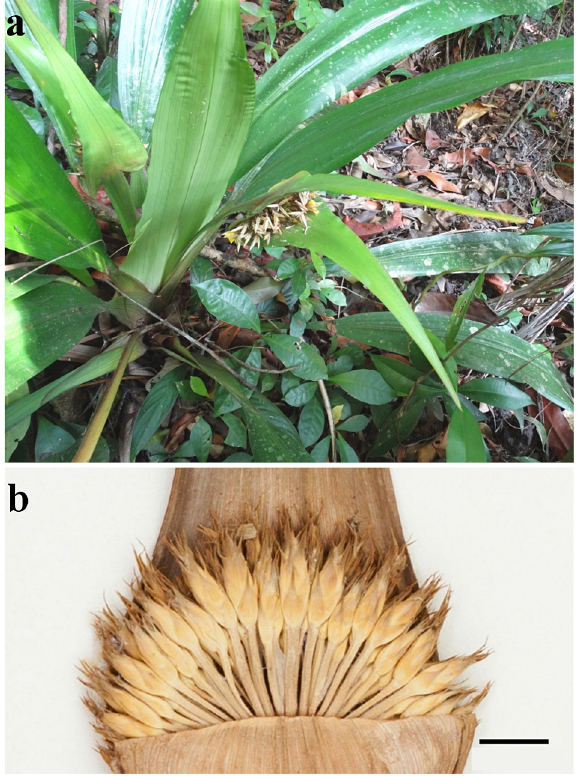
Figure 2. Rapatea paludosa Aubl. (MAR 11120). a. The plant in its natural habitat. b. Capituliform inflorescence, side view (photo- graphs by GPL and AWCF). Scale bar = 1